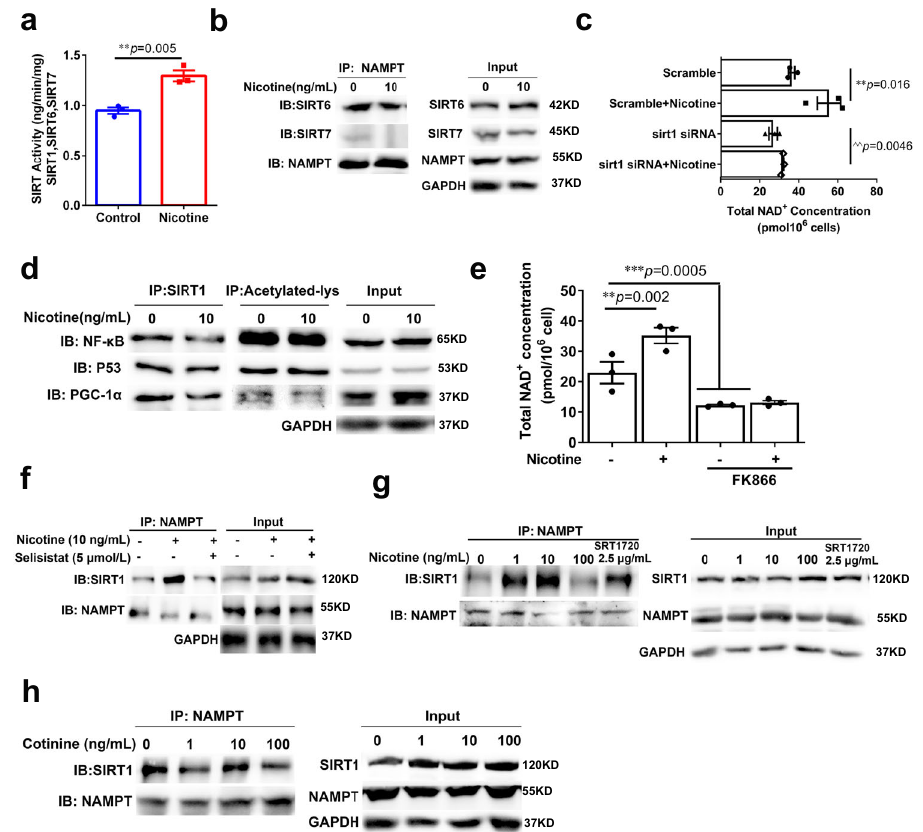
Fig. 5 | The speci fi c effect of nicotine on SIRT1-NAMPT interaction. a Nuclear SIRTUIN (SIRT1, SIRT6, SIRT7) activity of aged mice brain with or without nicotine at13monthsofage( n =3,biologicallyindependentsamples/group). b Nicotinehas no district effects on NAMPT-SIRT6/ SIRT7 interaction. c The total NAD + levels of SIRT1 knockdown cells after nicotine treatment ( n =3, biologically independent samples/group). d Nicotine (10ng/mL) has no district enhancement on SIRT1 interact with other substrates (p53, PGC-1, NF- κ B). e The NAMPT inhibitor FK866